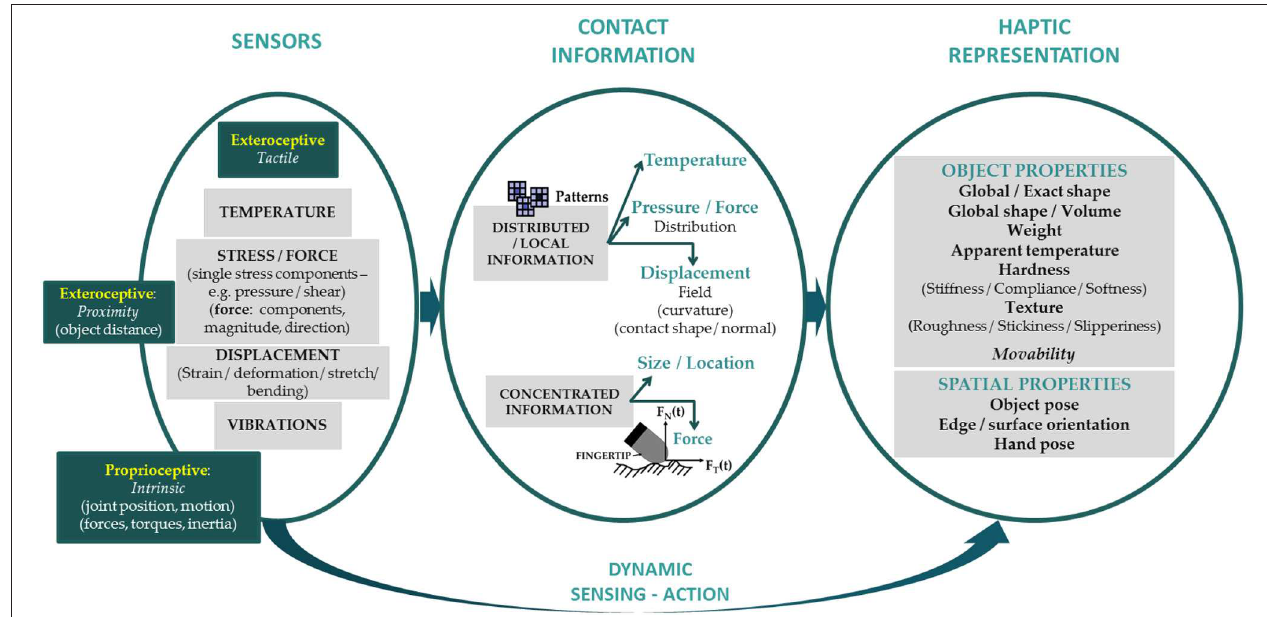
FIGURE 2 | The artificial sensory apparatus related to robot touch dynamically measures information about contact: the picture illustrates the route from sensor outputs to a system haptic representation. The sensor block includes an improved taxonomy, borrowing some details from a scheme introduced by Kappassov et al. (2015) (with permission from the authors). It contains information about all sensor types that are relevant for haptics (i.e., both proprioceptive and exteroceptive sensors) and specifies what tactile sensors in particular measure at their positions (raw sensor data), i.e., temperature, stress/force, displacement and/or vibrations. Distributed or concentrated information related to contact is generally the result of applying algorithms to sensor outputs. Higher level feature extraction allows for task-dependent haptic representation of the system state, including haptically accessible object properties and the spatial properties of both the touched object and the agent for touch. All categories for object properties (in bold) are derived from Lederman and Klatzky (2009). The intent here is to present an overall perspective, opening different routes on possible integrated approaches. Analyzing how to practically integrate these approaches with their benefits and drawbacks is beyond the scope of this